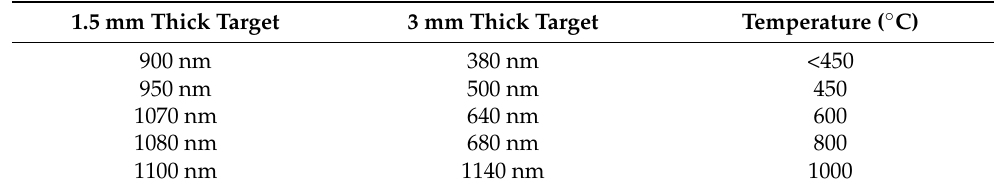
Table 3. Nickel coatings thickness deposited during the HTMS processes.